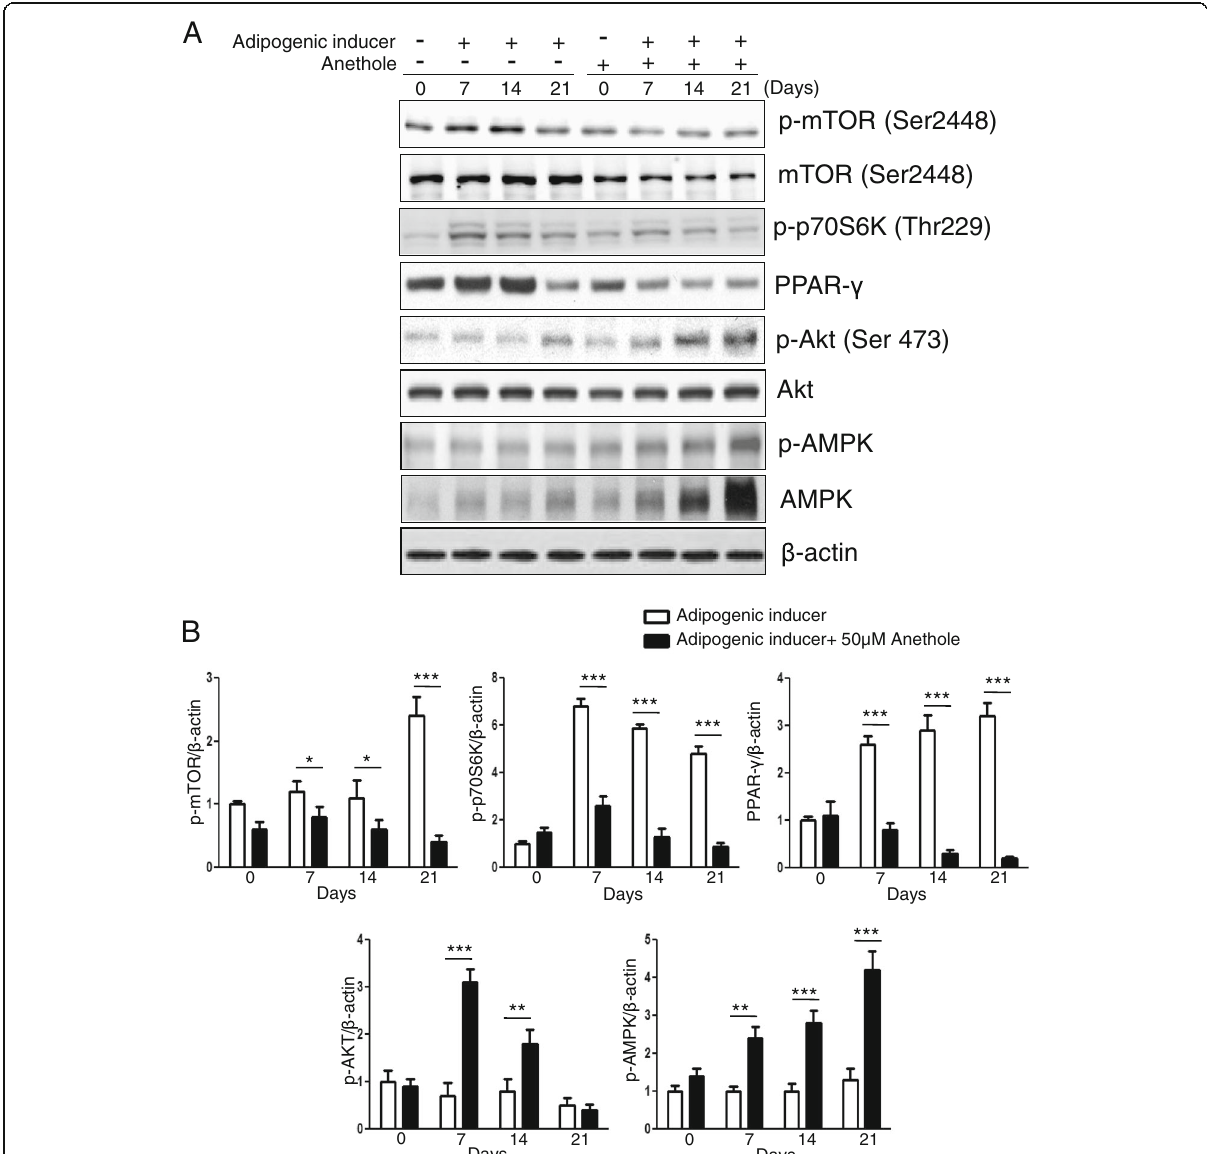
Fig. 2 Western blot analysis of anethole on adipogenic differentiation in hMSCs. a hMSCs were pretreated with 50 μ M anethole and incubated in adipogenic media for 4 weeks. Once a week, whole cell pellets were lysed in lysis buffer and immnoblotted for p-mTOR, mTOR, p-p70S6K, p70S6K, PPAR- γ , p-Akt, Akt, p-AMPKand AMPK. b The phosphorylated expression of each protein was caculated by dividing the total form of corresponding protein, and was normalized by β -actin. The relative folds were measured and calculated using Image J. Each experiment was repeated three times and the values are presented as mean ± S.D. ** p < 0.05, and *** p <